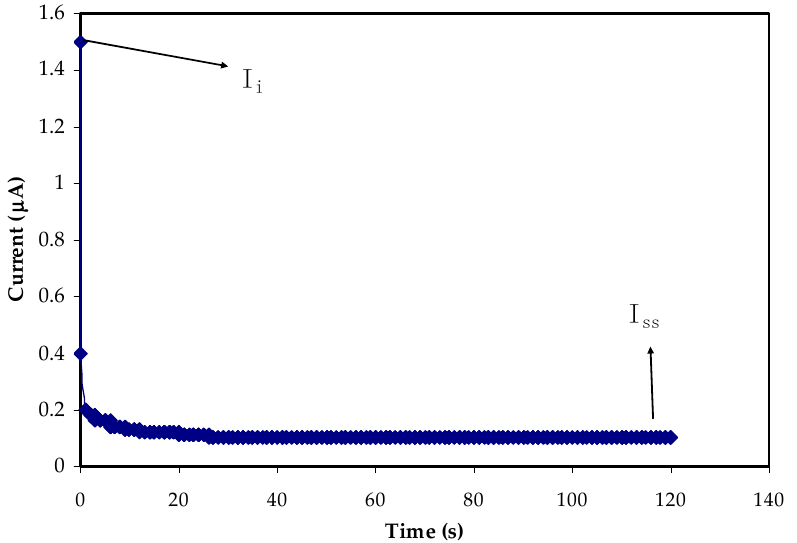
Figure 6 . Polarization of the highest conducting electrolyte at 0.2 V. Figure 6. Polarization of the highest conducting electrolyte at 0.2 V.